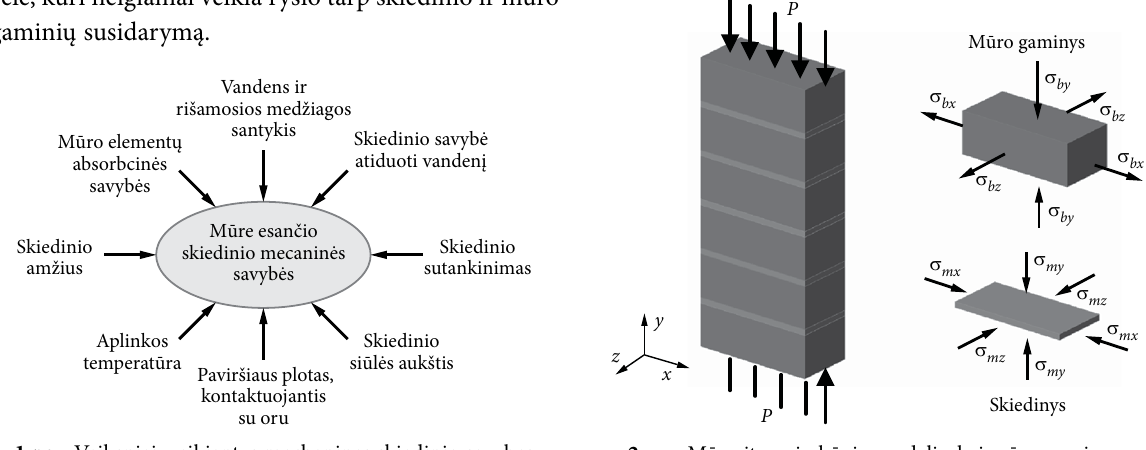
Fig. 1. Factors that have influence on properties of mortar inside masonry (Huster 2000)